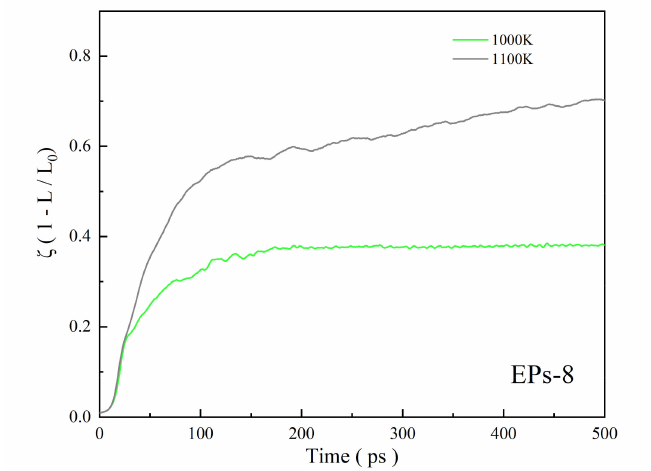
Figure 6. Shrinkage ( ζ ) of equally sized nanoparticles with a diameter of 8 nm during surface premelting sintering and liquid-phase sintering.